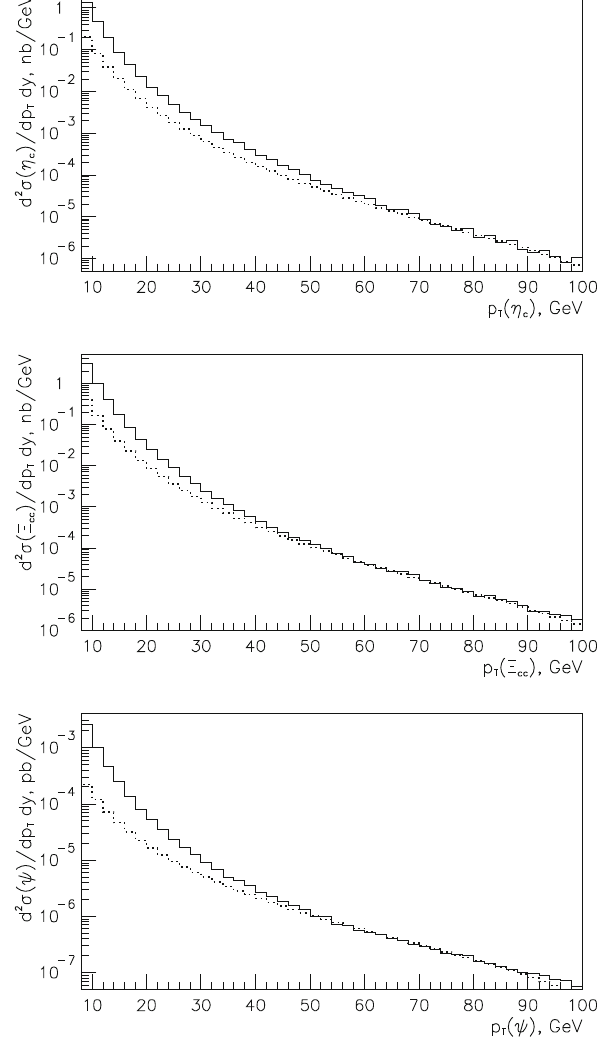
Fig. 10 Transverse momentum distributions of the different particles produced at the middle rapidity in pp or ee collisions at The full O (α 4 s ) calculation is shown by solid curves. The fragmentation approximation is presented by dashed curves. The plots from top to bottom correspond to the subprocesses g + g → η c + c + ¯ c , g + g → Ξ + ¯ c + ¯ c , and γ + γ → J /ψ + c + ¯ cc